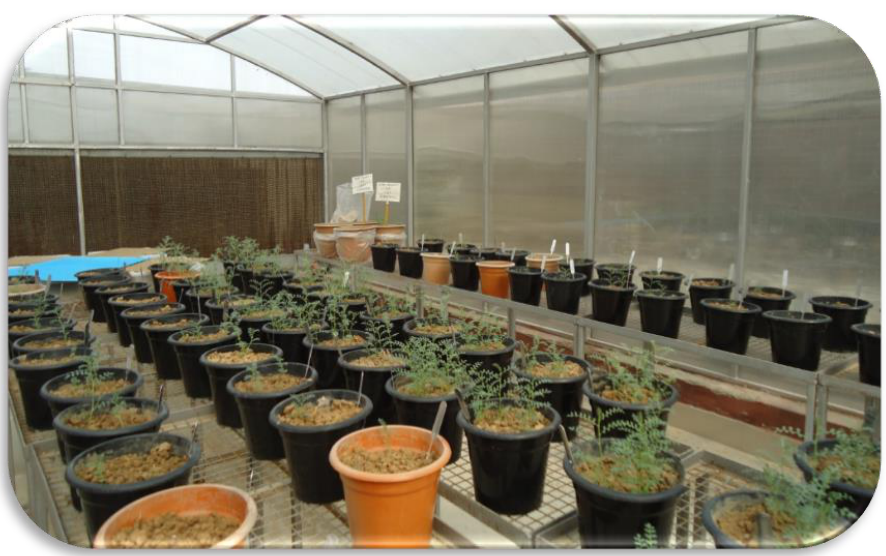
Figure 1. Pot screening for drought stress tolerance in chickpea genotypes under glasshouse condi- tions. Table 1. List of chickpea genotypes.